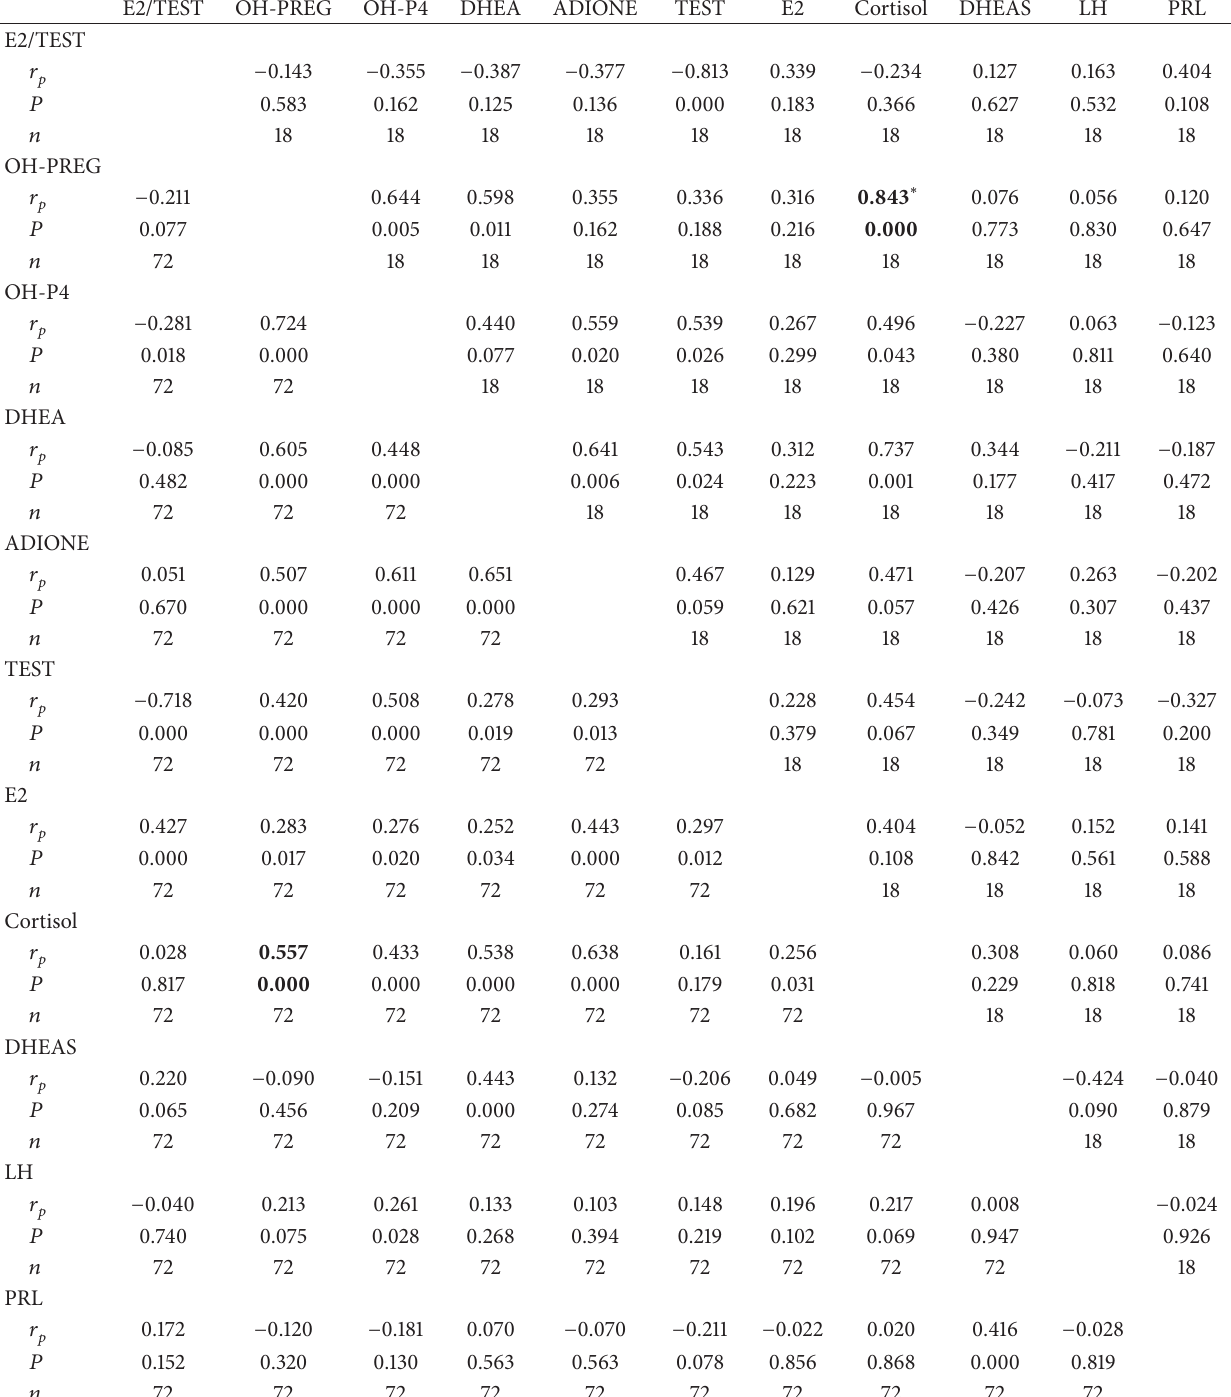
Table 2: Age-adjusted partial correlations of log-transformed hormones in male pre-RA (top) and CN (bottom) ∗ .